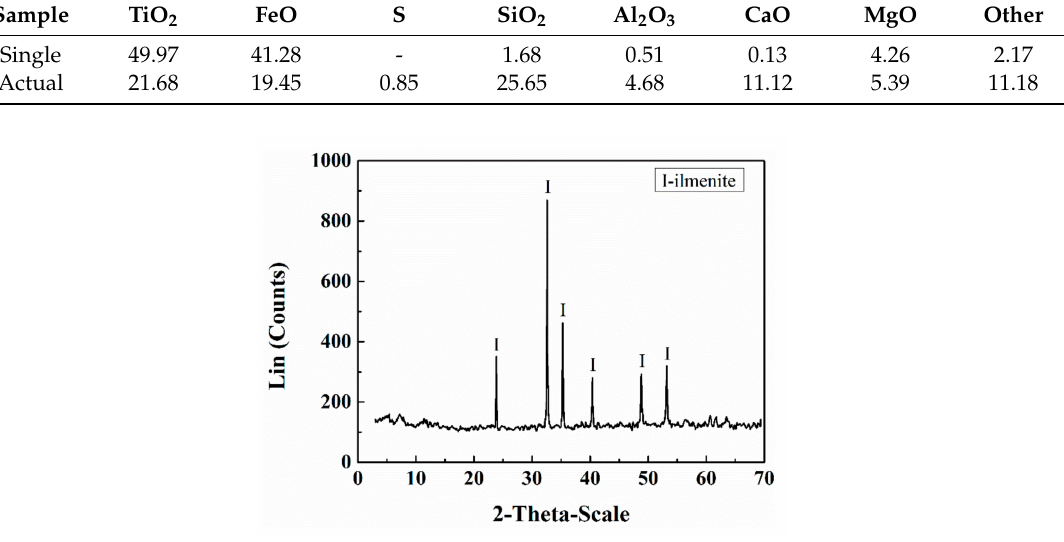
Figure 1. XRD pattern of single ilmenite samples in this